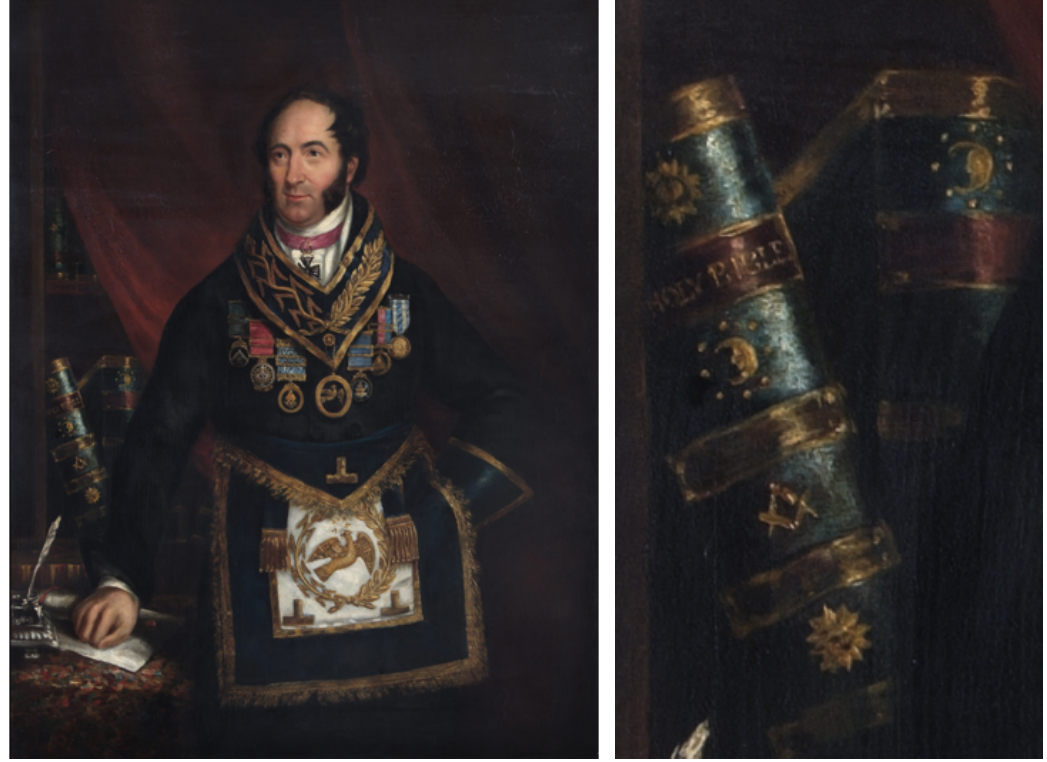
Fig. 1a. A portrait in oils of freemason Robert Crucefix. Copyright and reproduced by permission of the Museum of Freemasonry, London. M2008/249.